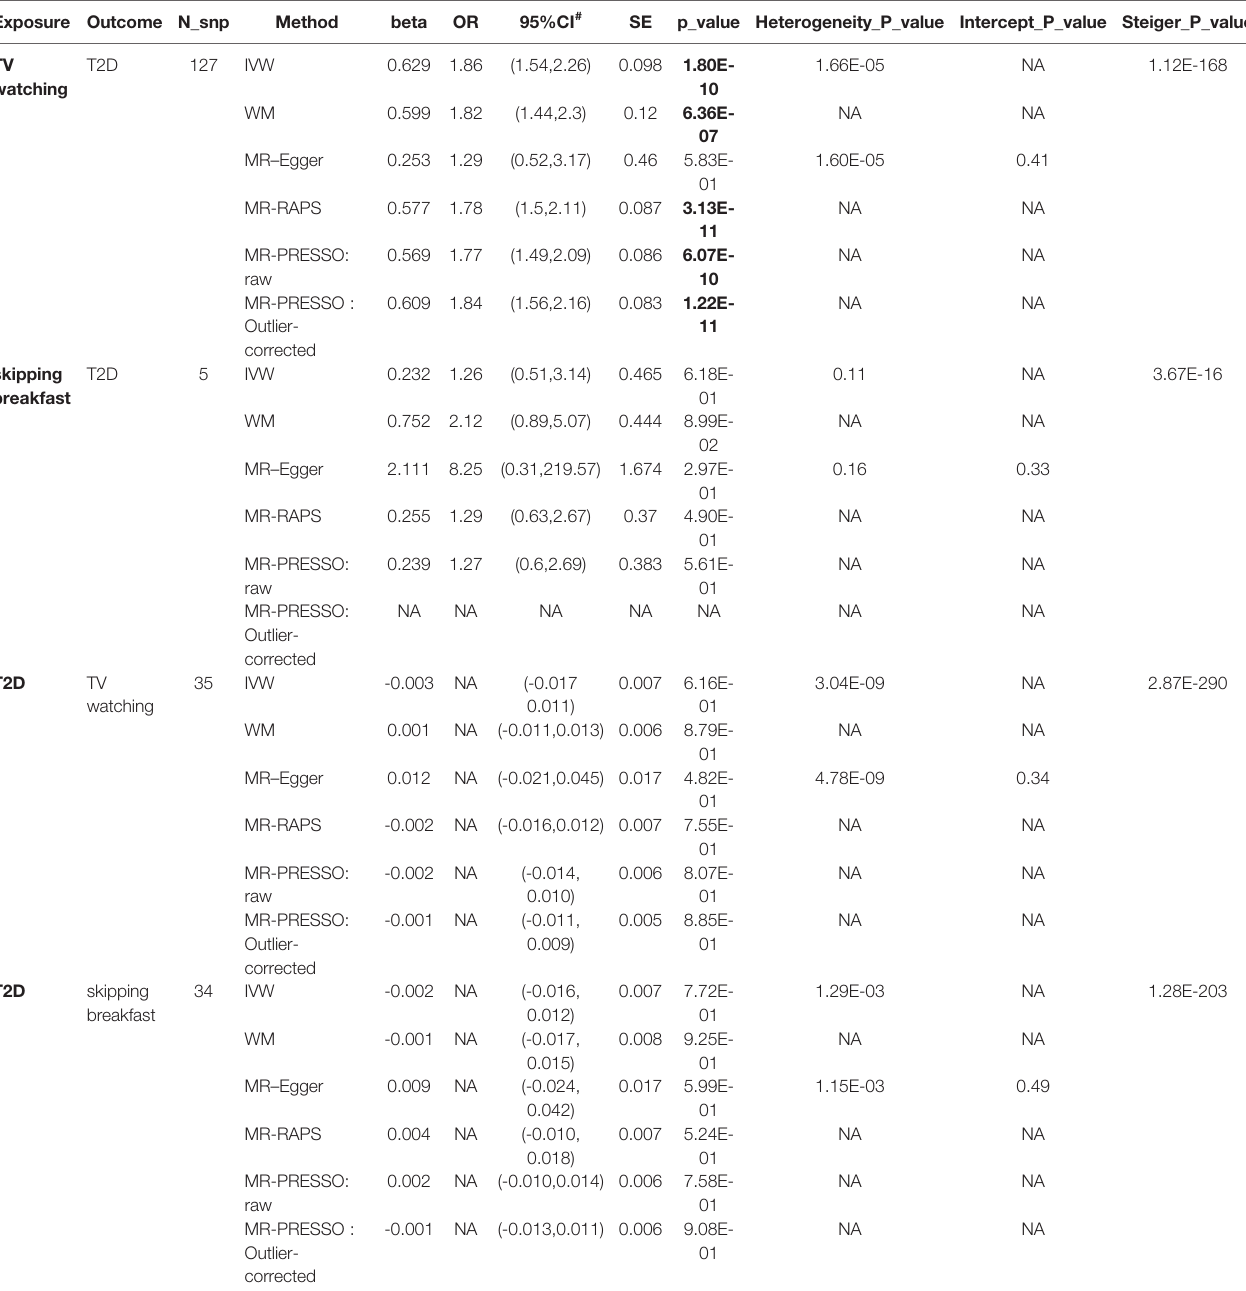
TABLE 2 | Causal relationships between TV watching, skipping breakfast and T2D ( fi ndings adjusted for multiple comparisons). Exposure Outcome